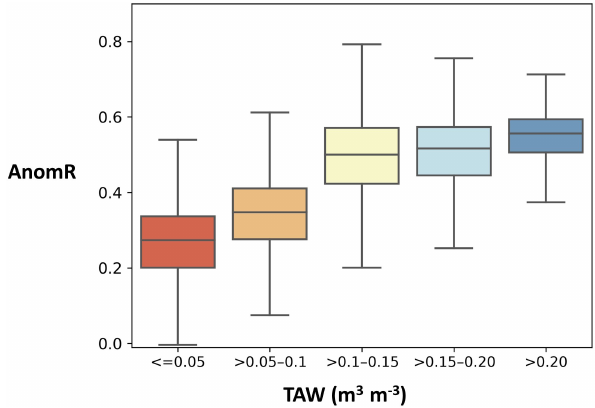
Figure 4. Box plots showing the distribution of biomass anomaly correlations for the northern half of the study domain (46–55 ◦ N), grouped by different TAW